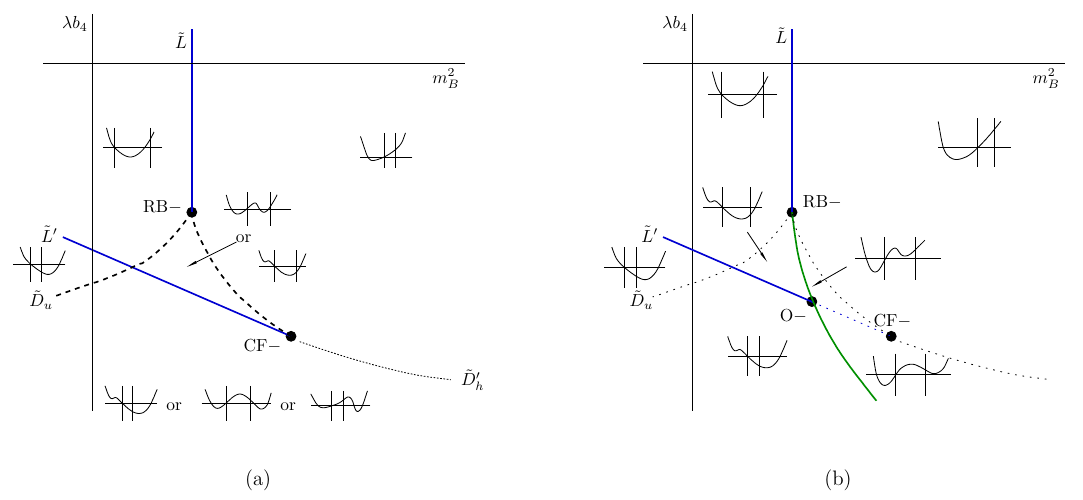
Figure 11. Deducing the phase structure for the m F = (cid:0)j (cid:22) j sgn( (cid:21) ) section for j (cid:21) j < 1 inset plots are the pro(cid:12)les of the potential (4.19). The two vertical lines in each plot correspond to (cid:27) = 0 and (cid:27) = (cid:0) m F = 2 (cid:21) respectively from left to right and demarcate the regions of validity of the ( (cid:0) ; +), ( (cid:0) ; (cid:0) ) and (+ ; (cid:0) ) branches of the potential (4.19) (cf. (cid:12)gure 9). The green line in (cid:12)gure (b) corresponds to a numerically-determined (cid:12)rst order transition line.